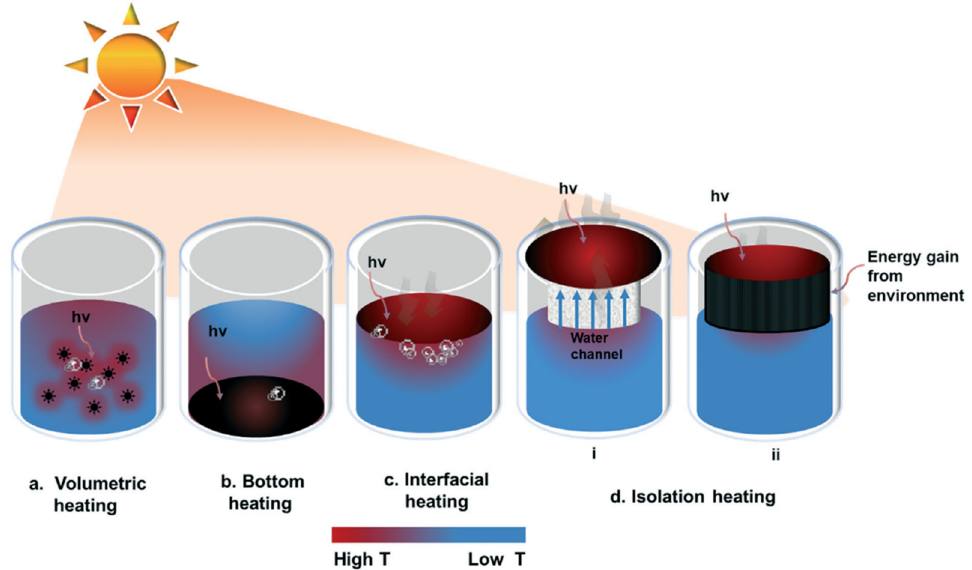
Figure 3. Solar-driven evaporation systems. Reprinted with permission from Ref. [29]. Copyright 2022 Royal Society of Chemistry.